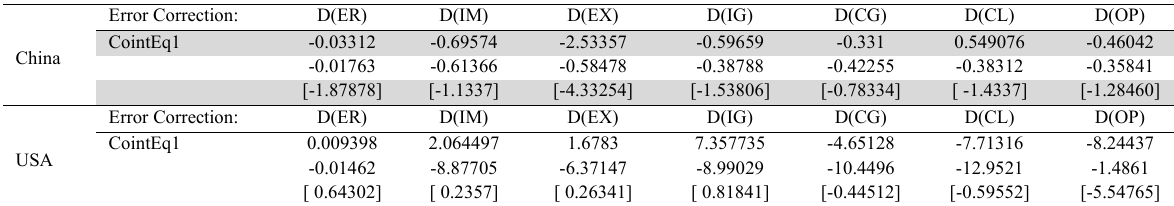
Vector Error Correction